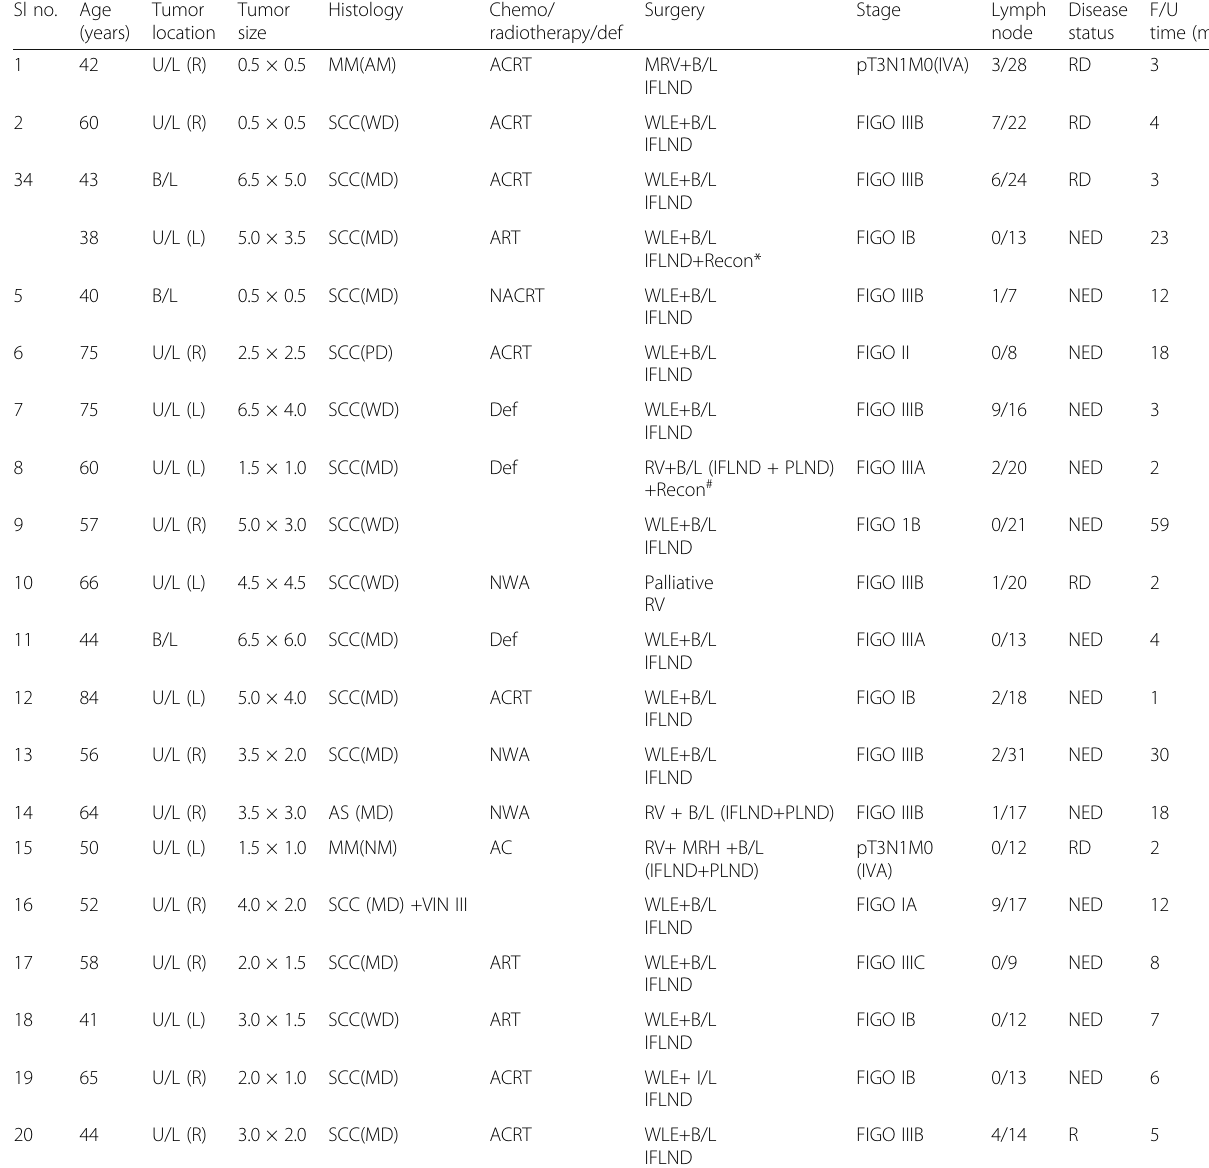
Table 2 Correlation of clinical features, disease characteristics, treatment, and disease status Sl no. Age Tumor Tumor (years) location size